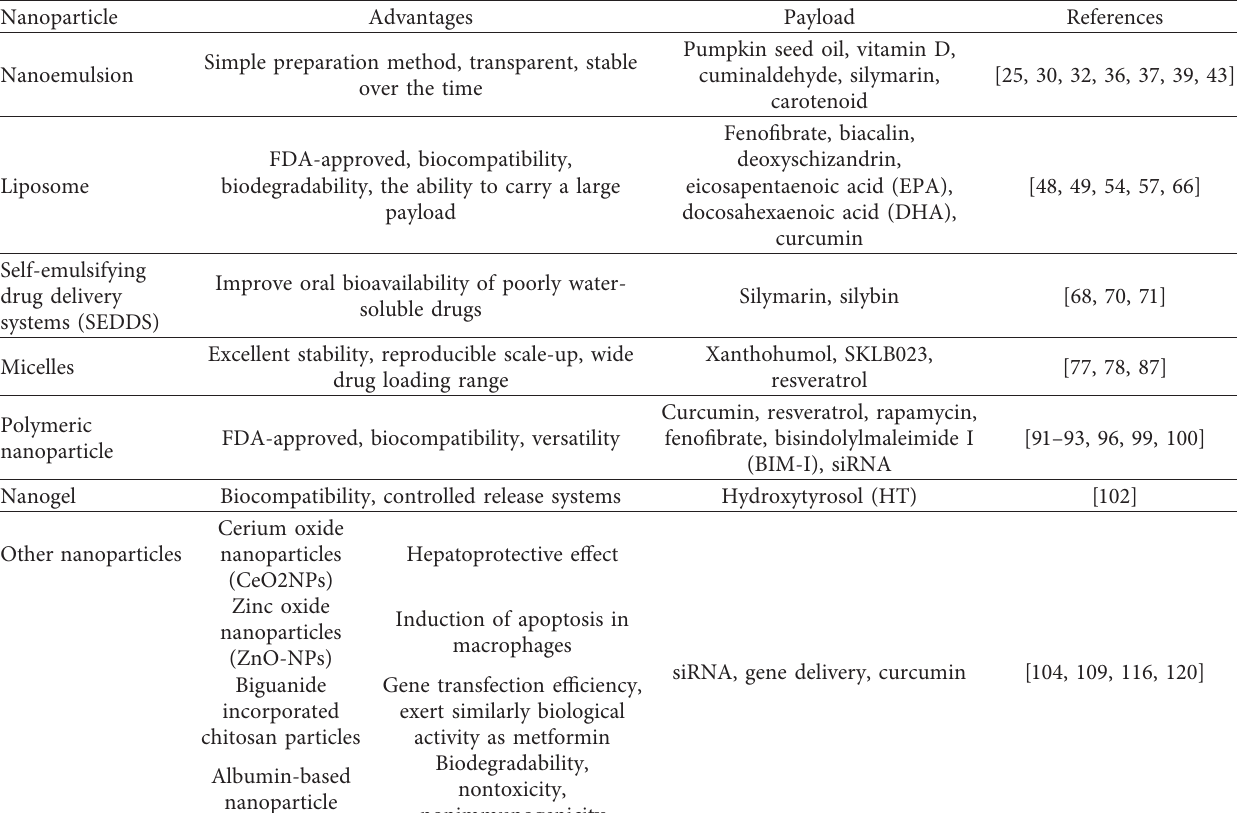
Table 1: Nanoformulation approaches designed to improve treatment efficiency in NAFLD.